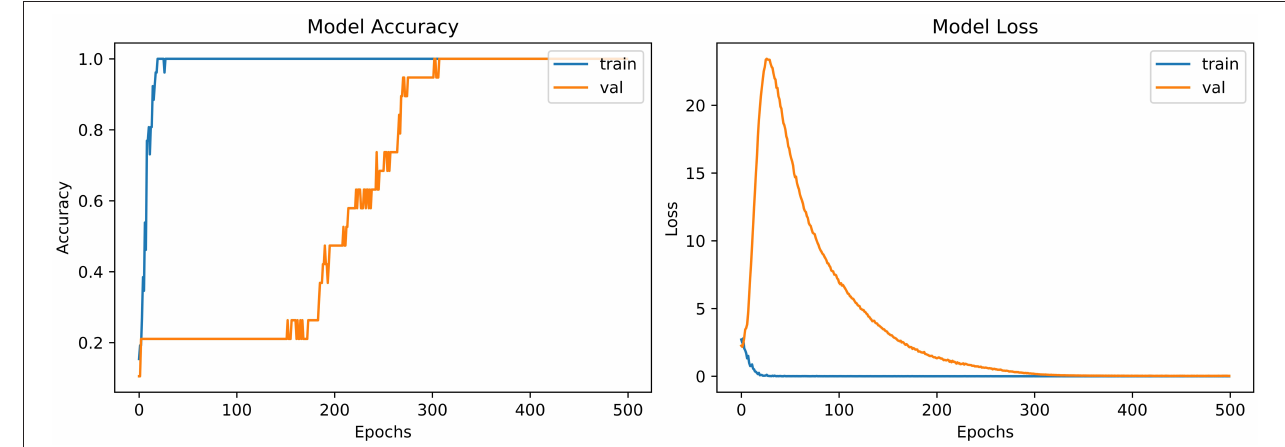
FIGURE 5 | Model accuracy and model loss for AlexNet.